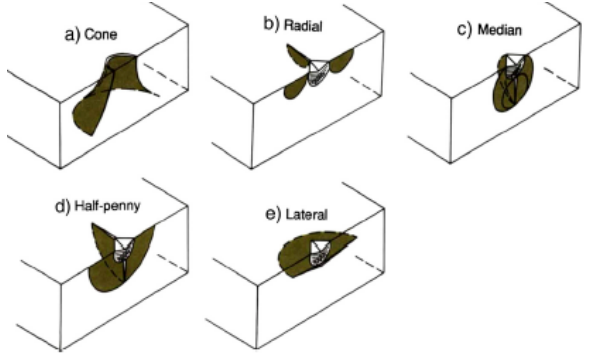
Figure 12. Typical fracture types during indentation of brittle materials, where ( a–e ) shows the forms of cracks generated on the surface. Reproduced with permission from [31]. Elsevier, 2014.